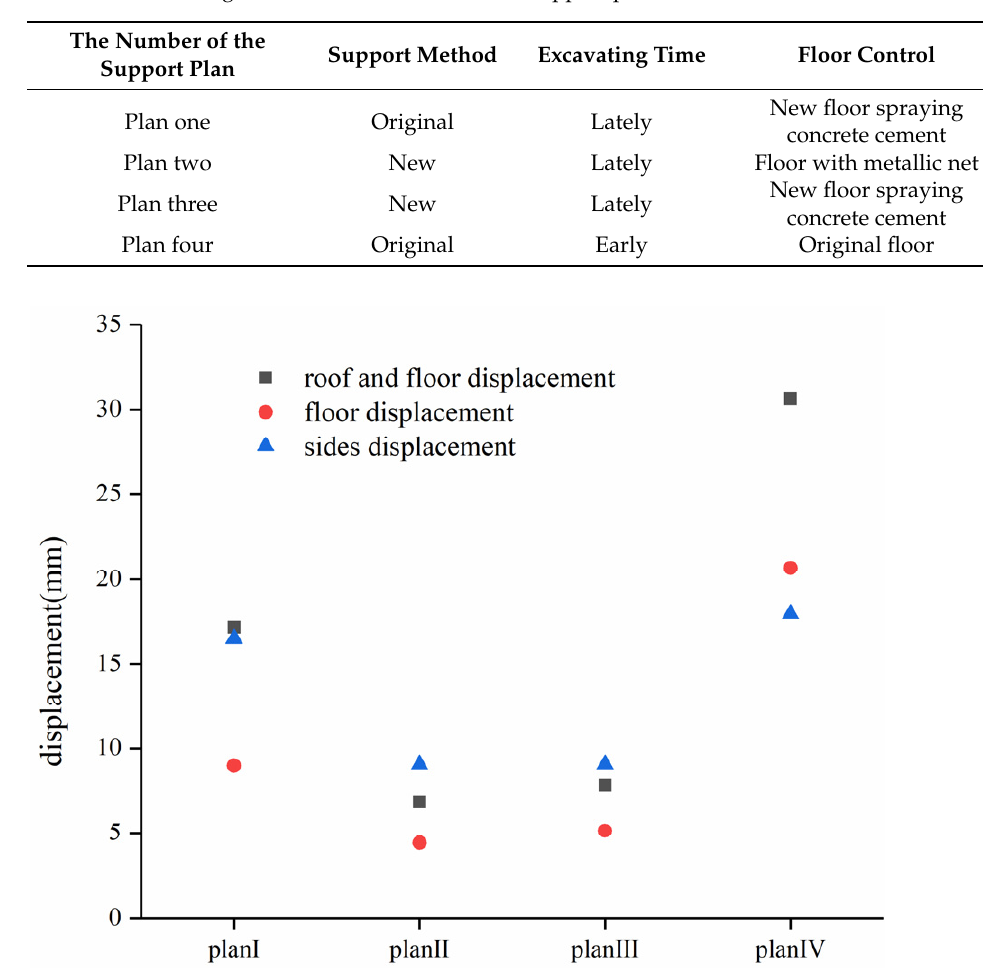
Figure 15 . The new support scheme and support parameters